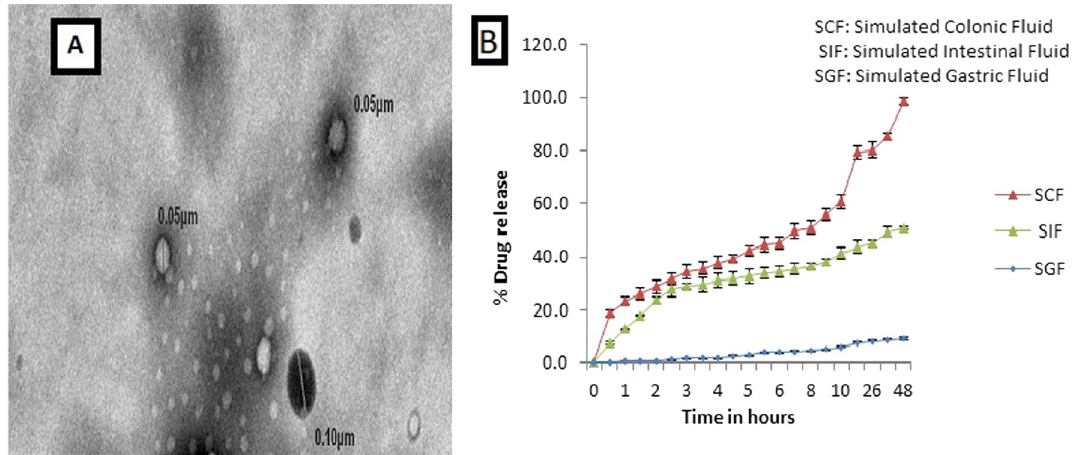
Fig. 1 A TEM images of CsENP B In vitro drug release of SN-38 from CsENP [18]